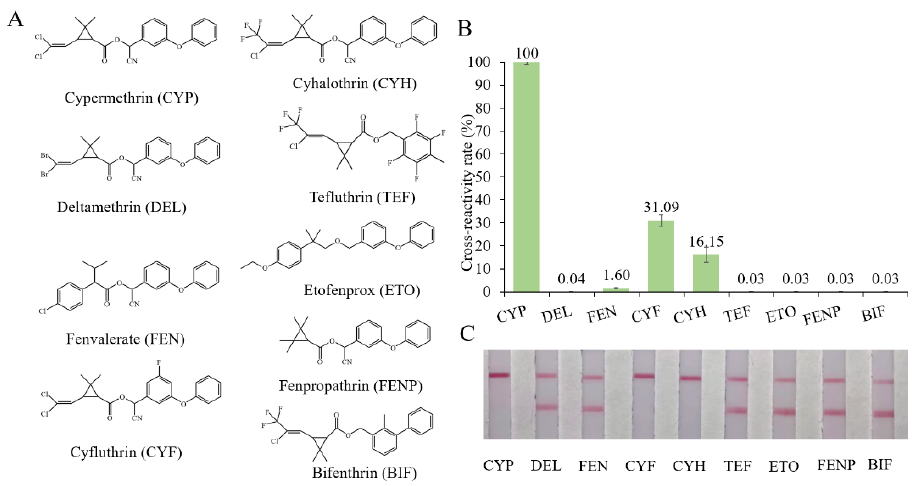
Figure 3. The cross-reactivity of the ic-ELISA and LFIA. ( A ) The cross-reactivity rates of ic-ELISA. ( B ) The specificity of LFIA. ( C ) The chemical structures of CYP and its analogues.